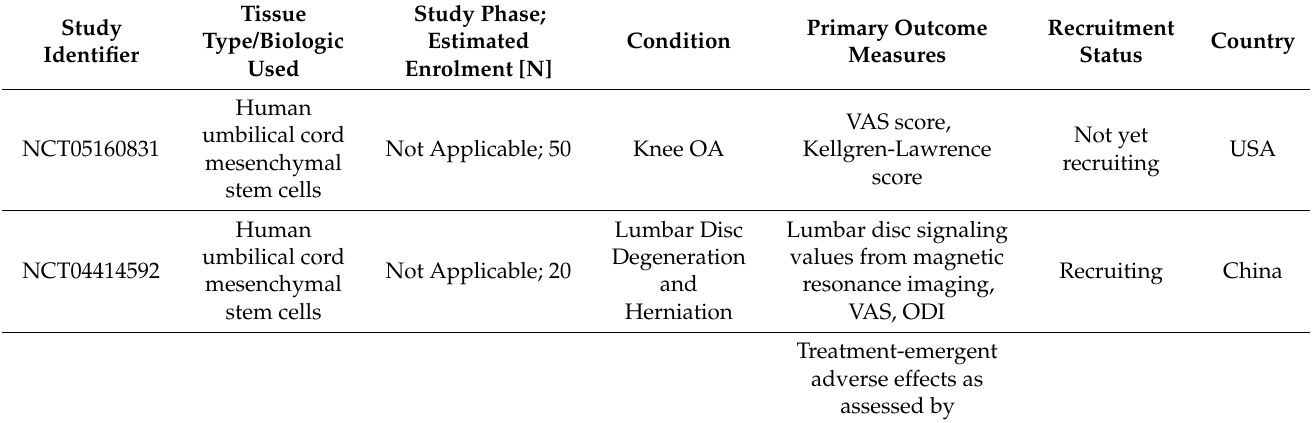
Table 1. Clinical trials registered on ClinicalTrials.gov till 10 October 2022 utilizing umbilical cord tissue/cells, and its derivatives, for the treatment of orthopedic